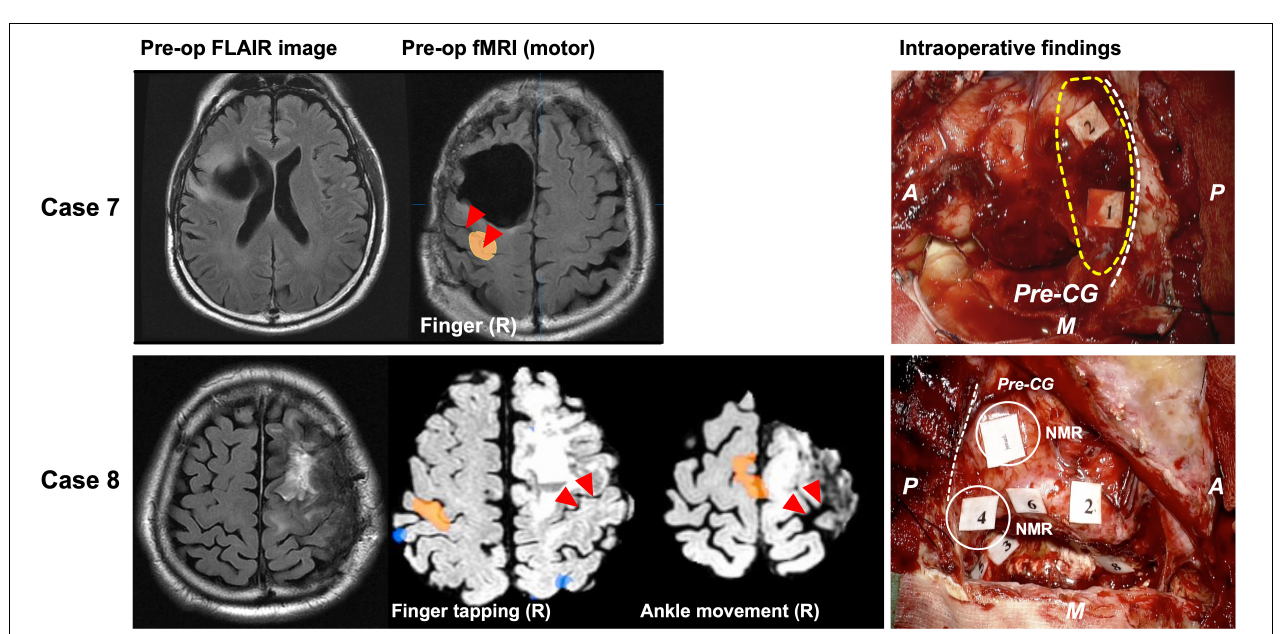
FIGURE 4 | Patients whose motor function moved according to Type 2. The left columns show the preoperative FLAIR images; the middle columns show the intraoperative findings; the right columns show the positive mapping sites for each patient’s brain reconstructed from structural MRI. In Case 5 (upper column), the motor area of the upper limb was observed next to the foot area. In case 6 (lower column), the face area was found between the hand and the wrist area. Green circle: positive mapping site of foot; cyan circles: positive mapping sites of upper limb including shoulder, arm, elbow, hand, and wrist; yellow circle: positive mapping site of face; red broken line: knob area in the precentral gyrus, namely, the hand area. A: anterior; P: posterior; M: medial side.